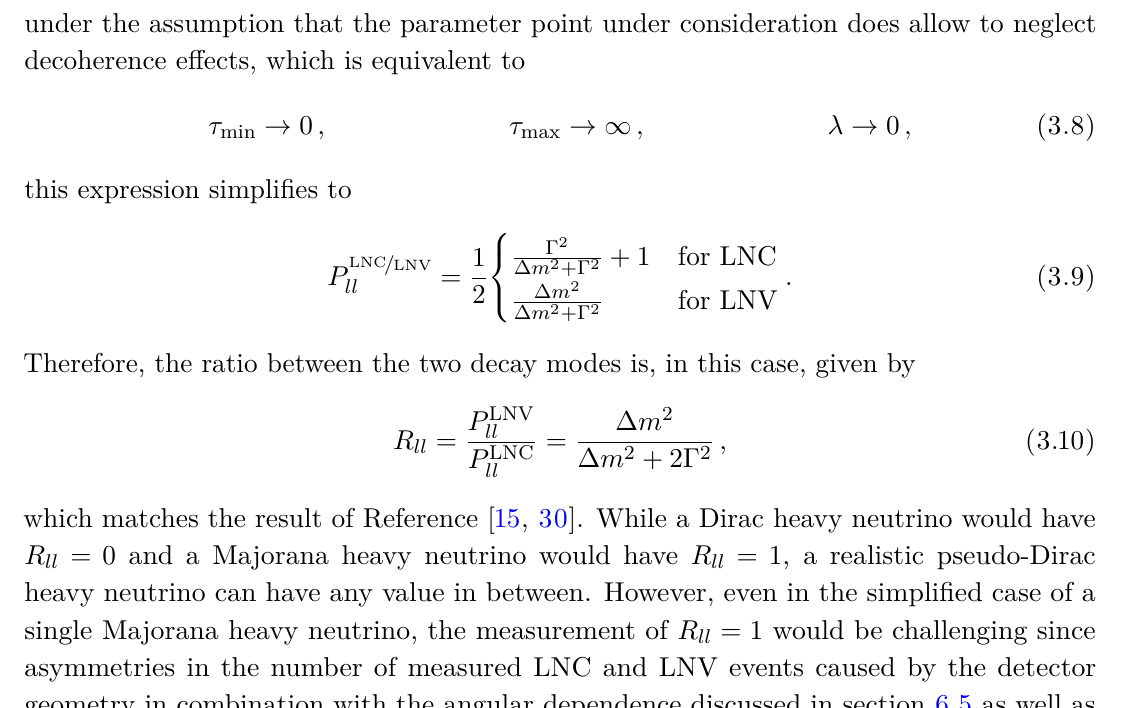
while in panel (b) τ max is variable and → ∞ R ll coincides with R obs and ll